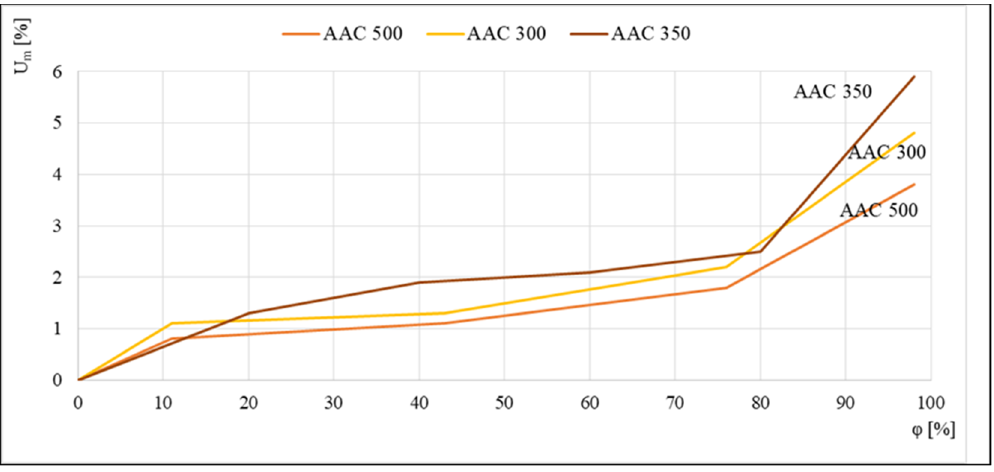
Figure 4. Sorption isotherms of class 300, 350, and 500 kg/m 3 aerated concrete, based on [19].